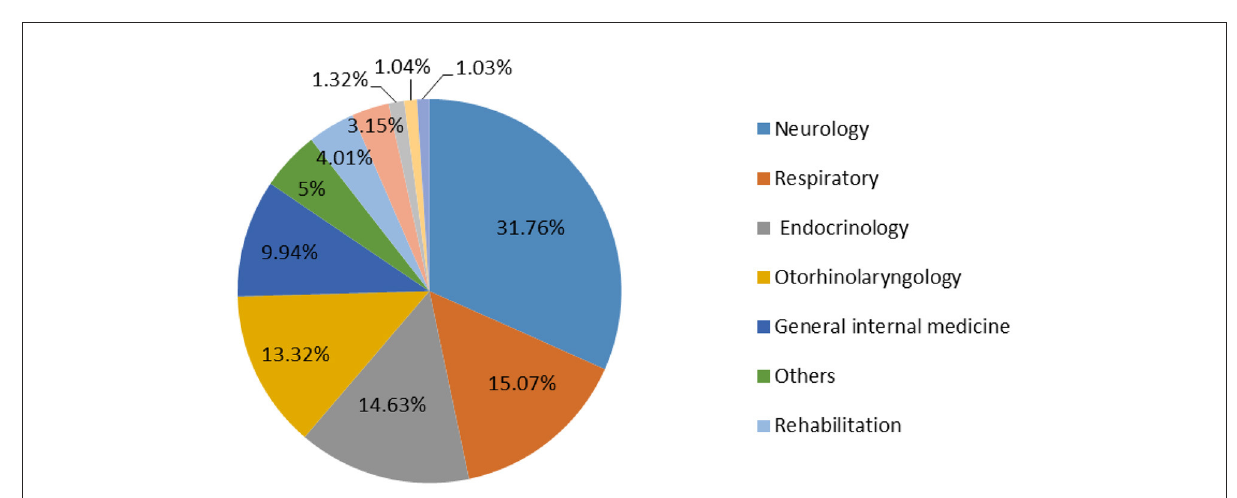
FIGURE4 Distribution of the top 10 departments for the online